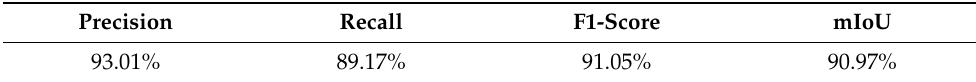
Table 2. Accuracy of EfficientUNet+ method for extracting buildings.